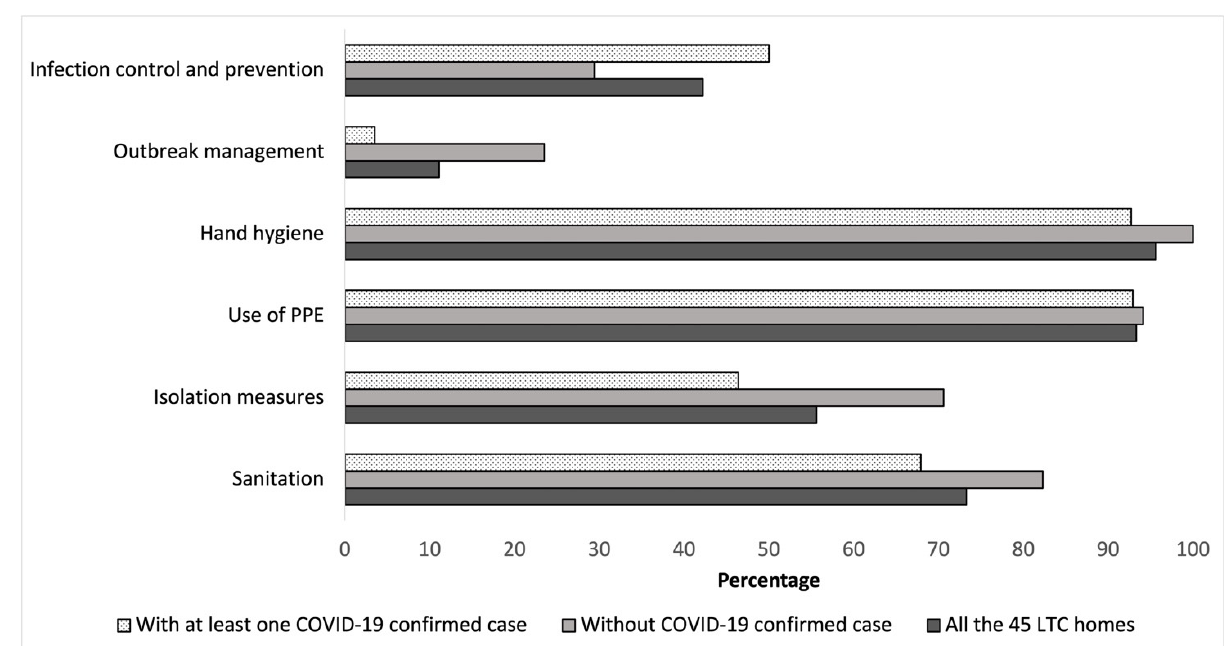
Figure 3. Percentage of LTC homes with official documents/guidelines by presence of at least one COVID-19 confirmed case.